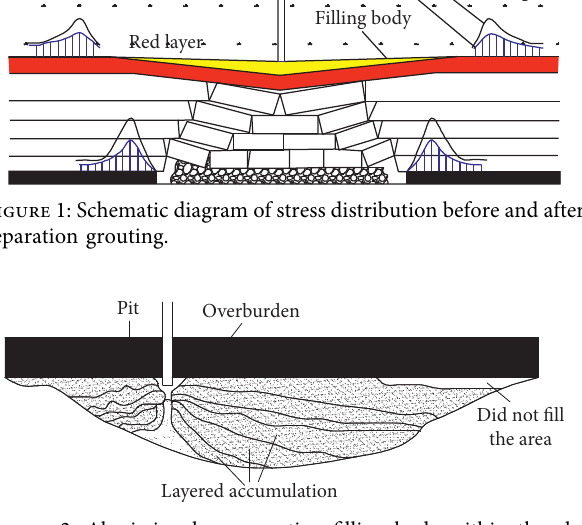
Figure 2: Abscission layer grouting filling body within the ab- scission layer distribution diagram form.